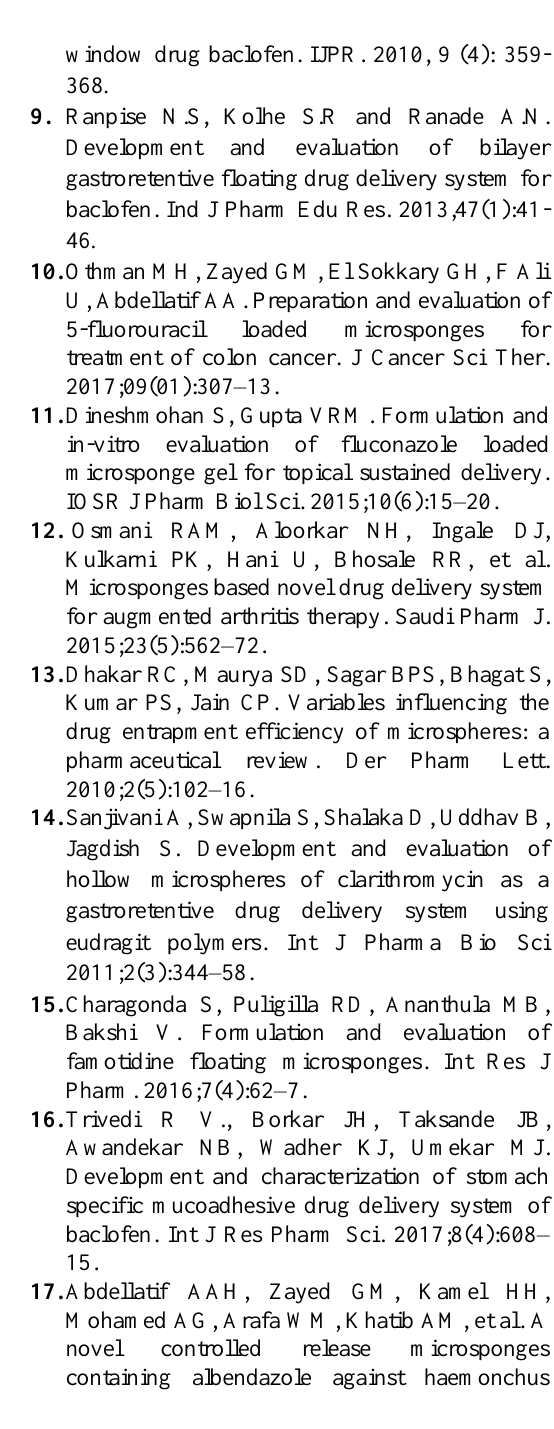
Table (7) Kinetic analysis of BFN floating microsponge tablet release data (FMT7)